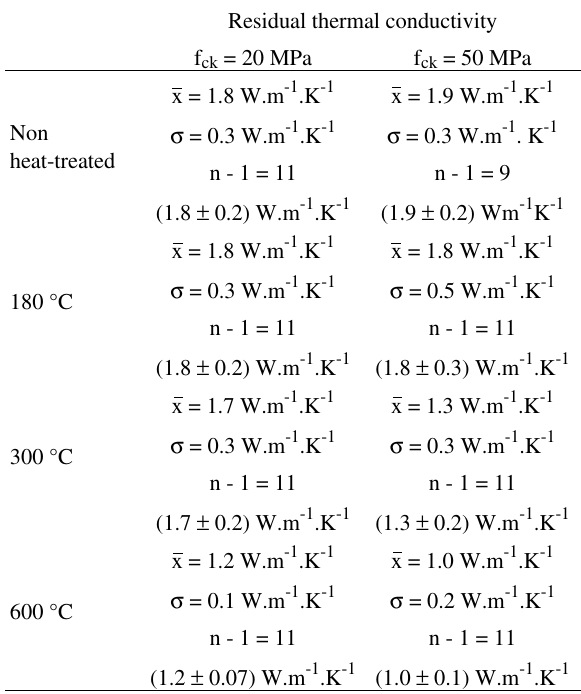
Table 2. Residual thermal